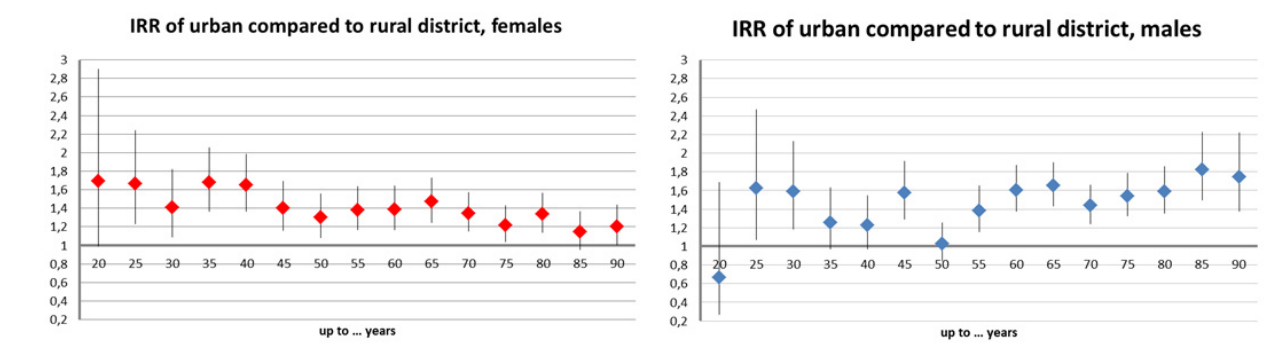
Figure 4. Age-group specific melanoma incidence risk ratios (IRR) and 95% confidence intervals (CI) in rural districts compared to rural districts: Raw incidence data controlled for altitude, year, and “Styrian” factors, and offset by the same year population number of the very group; females (left), males (right).